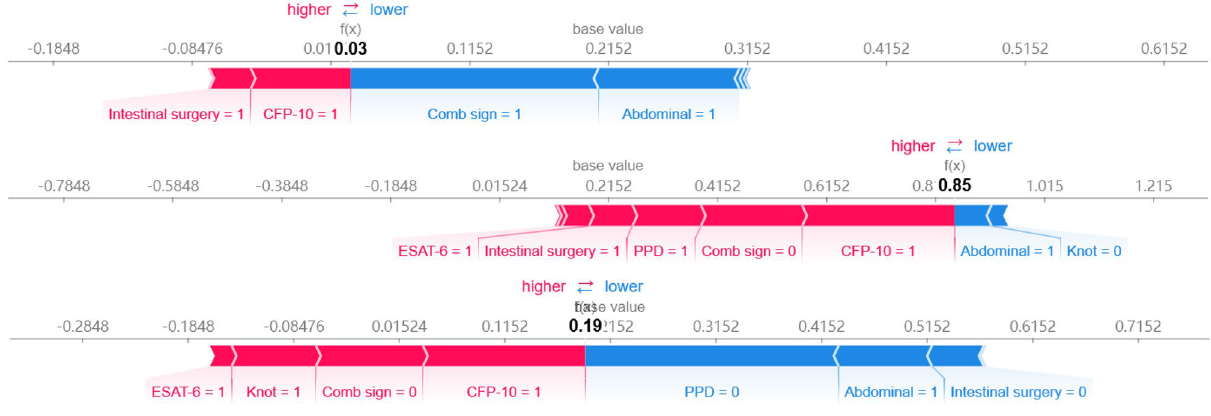
Figure 4. SHAP explanation plot for three patients from our testing